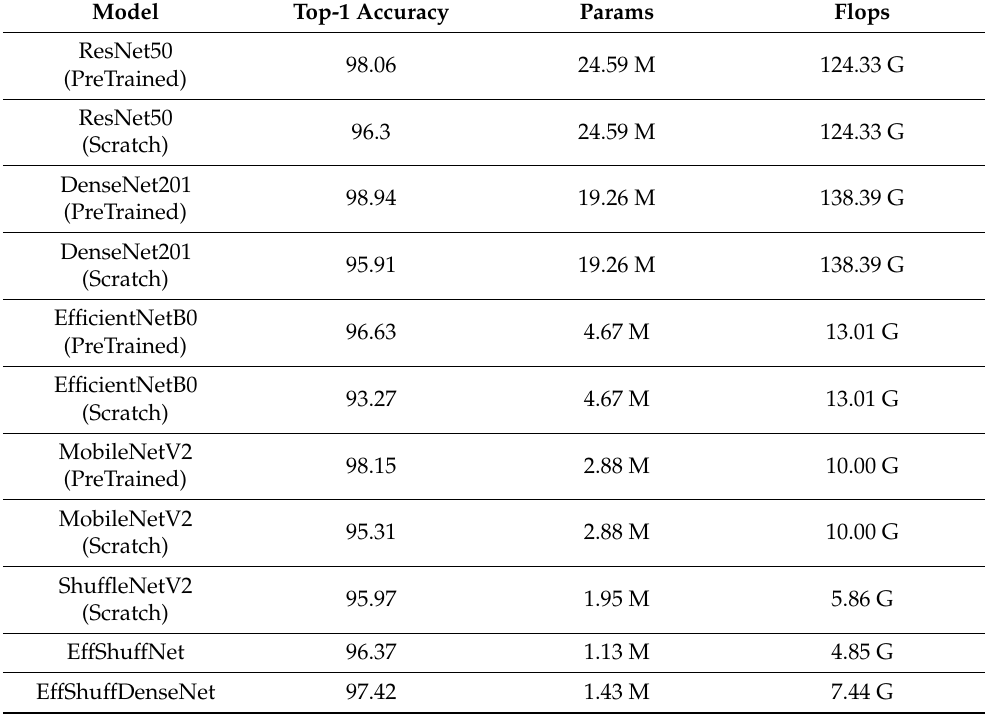
Table 3. Experimental results of age classification.